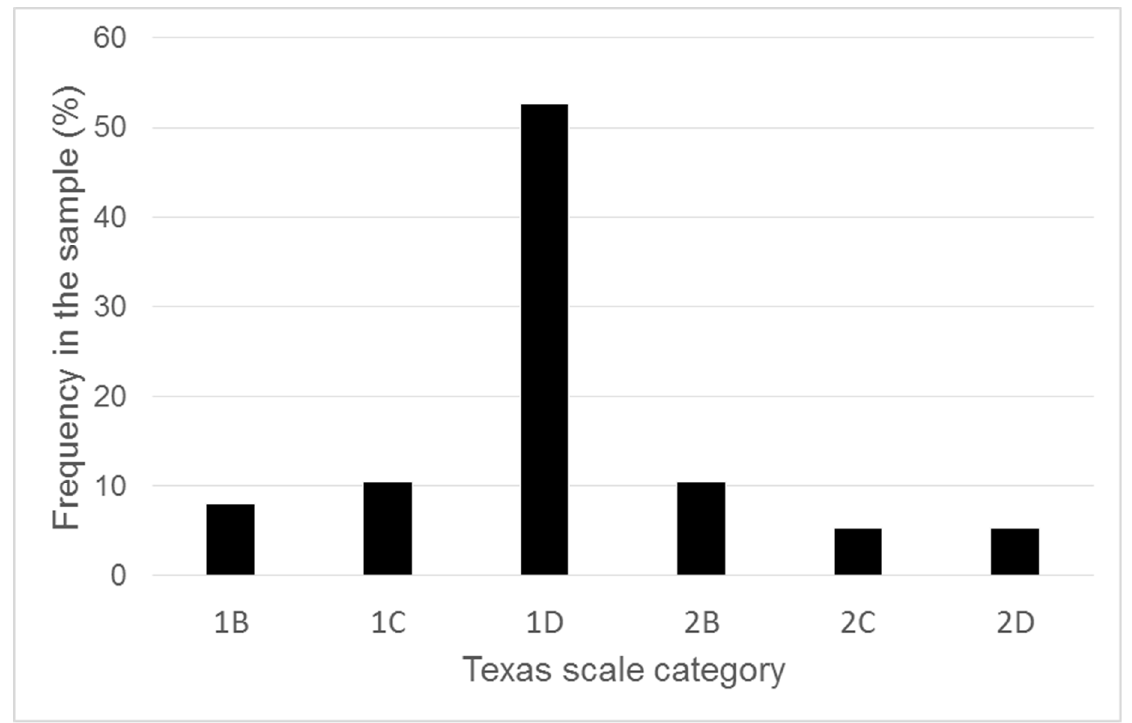
Chart 1. The frequency of each category of Texas scale in the sample of enrolled patients.